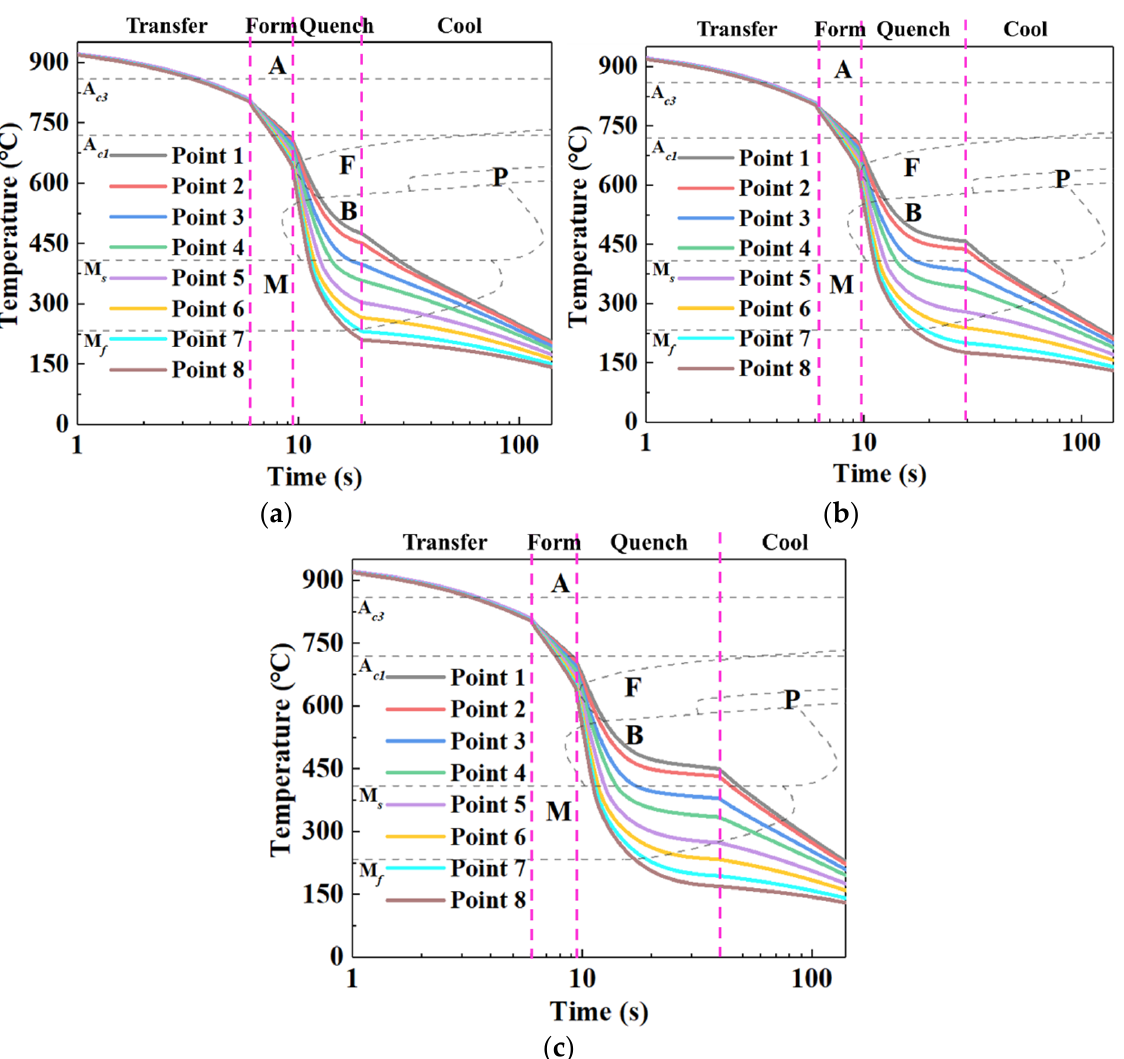
Figure 9. Temperature-history curves for sheet at eight temperature measuring points under different quenching times of ( a ) 10 s, ( b ) 20 s, and ( c ) 30 s.